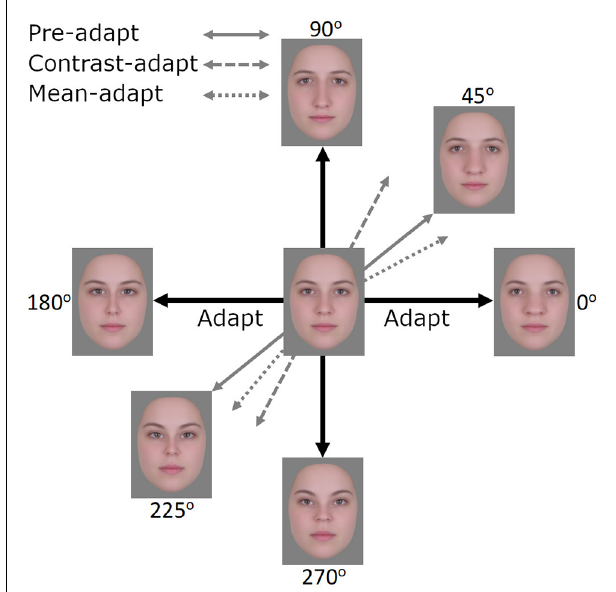
FIGURE 7 | After adapting to images along the 0 ◦ –180 ◦ axis, the expected effects of contrast adaptation would be observed as images along the 45 ◦ –225 ◦ axis appearing more similar to images along the 90 ◦ –270 ◦ axis, akin to a tilt aftereffect. If mean adaptation were to occur, perhaps in the form of the neutral point shifting towards the face at 180 ◦ , then the face at 45 ◦ would appear less similar to the 90 ◦ –270 ◦ axis and the face at 225 ◦ more similar to the 90 ◦ –270 ◦